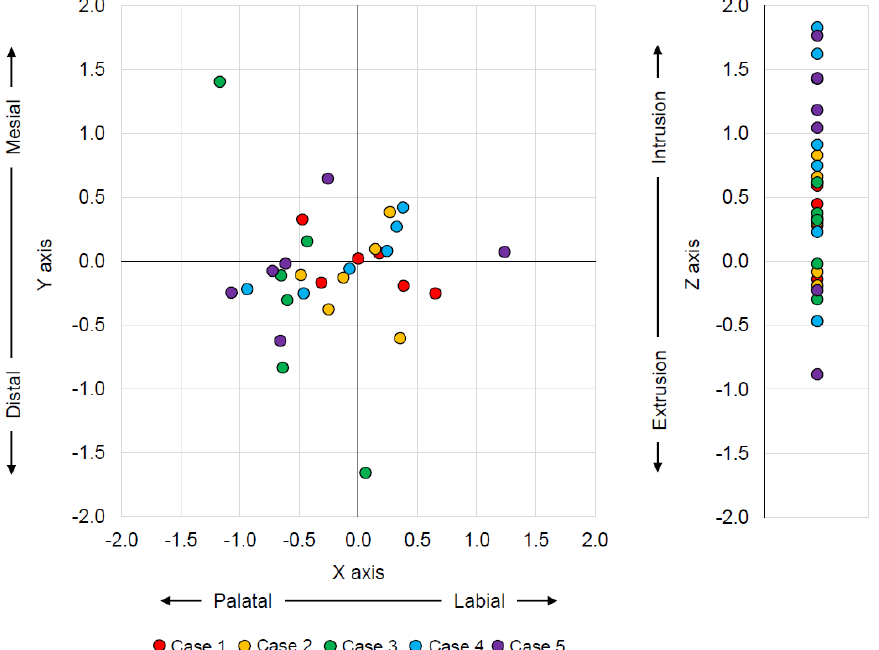
Figure 4. The distribution of the discrepancy between the test method and the current method on the X, Y, and Z axes with zero point as the current method. The X axis represents labial–palatal, the Y axis mesial–distal, and the Z axis apex/intrusion– incisal/extrusion discrepancies.